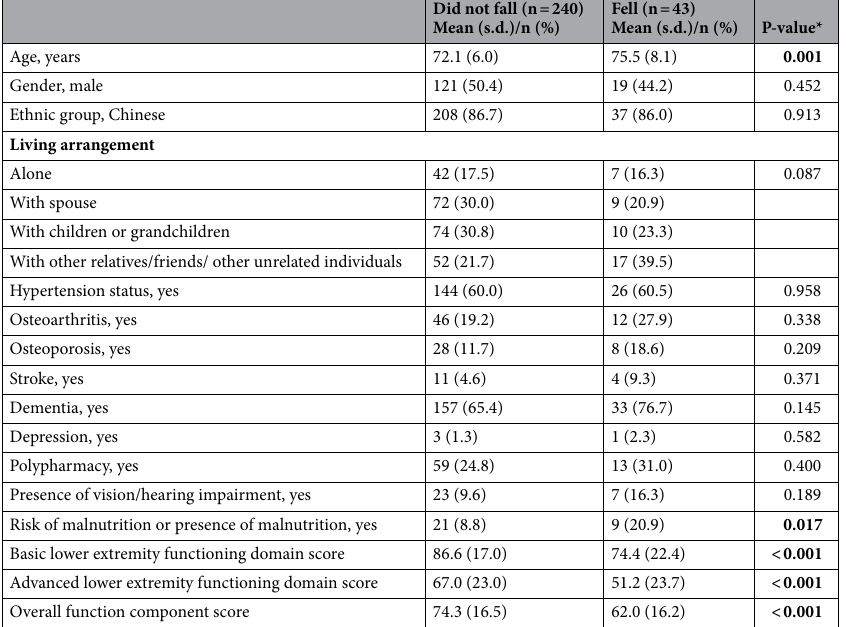
Table 1. Baseline characteristics comparing those who did not fall to those who fell. *P-value for differences between those who did not fall and those who fell, by t-test or chi-square test as appropriate. Bold values are statistically significant for P-value ≤